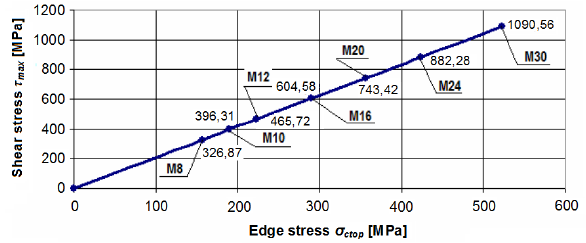
Figure 13: Dependency shear stress – adhesion stress for M8 ÷ M30 anchors in slab short